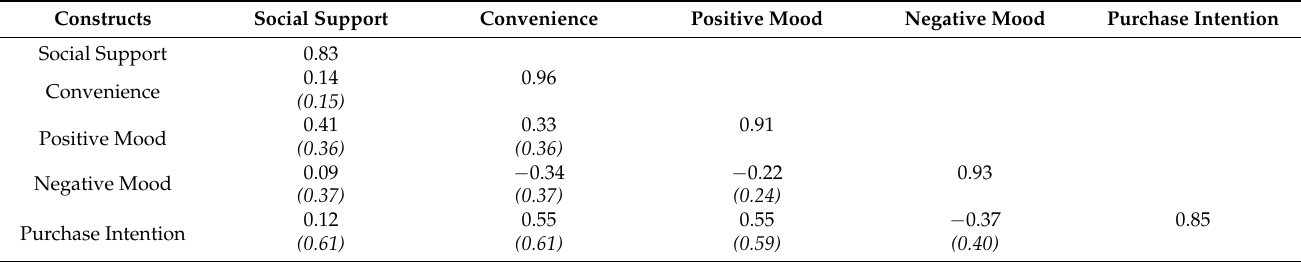
Table A5. Discriminant validity results for Neuroticism